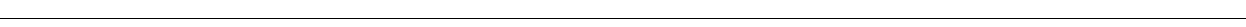
Fig. 1 Multipotent progenitor and NSC-like pro fi le of LAM and angiomyolipoma. a Hematoxylin and eosin (H&E) of the lung sections from sporadic LAM; GFAP or NSE expression in LAM. Arrows indicate LAM and arrowheads normal bronchial mucosa (upper) or normal pleura (lower images). b Sporadic angiomyolipomas (upper left and upper middle) and adjacent normal kidney (upper right) or TSC-associated (lower images) angiomyolipomas, stained with H&E or for NSE, GFAP, NS-tubulin, or nestin (arrows indicate angiomyolipoma and arrowheads kidney). c (i) GFAP, (ii) NSE and nestin expression in (i) TSC-associated and sporadic (ii) angiomyolipomas (T) from patients (P) vs. normal kidney (NK) by western immunoblotting. d (i) Nestin and peripherin expression in LAM ( fi rst left) and co-expression analysis by digital pathology; red indicates peripherin (second), brown nestin (third image), and yellow indicates co-expression of both markers (markup, right fi fth panel: details within the area marked by the corresponding insert in fourth panel, black arrows). (ii) Quanti fi cation for data shown in d (i) by Aperio Digital Pathology; the percentage of area with co-expression of peripherin and nestin in LAM from 9 patients. Error bars are de fi ned as means+ s.e.m. e (i) FACS of cells grown in DMEM medium. Percentages of 621 – 101 and CRL4004 (angiomyolipomas- derived) cells expressing nestin alone or co-expressing: melan-A, GFAP, SMA, and NS-tubulin; (ii) Nestin, GFAP, and NS-tubulin expression in 621 – 101 (grown in DMEM or IIA complete medium), CRL4004 angiomyolipoma cells, angiomyolipoma tumor, and corresponding normal kidney by western immunoblotting. Error bars are de fi ned as means + s.e.m. f q(RT)-PCR of SOX10 , SOX9 , ID3 , NESTIN , c-Kit , DCT , and S100A1 mRNA levels relative to 18S in 621 – 101, CRL4004, angiomyolipoma tumor, and corresponding normal kidney. Data represent means ( ± s.e.m.). Data from nine LAM and eleven angiomyolipomas ( a – d ). Scale bar: 50 µ m. * P ≤ 0.05, t- test. Data are representative of three to six ( e (i)) independent